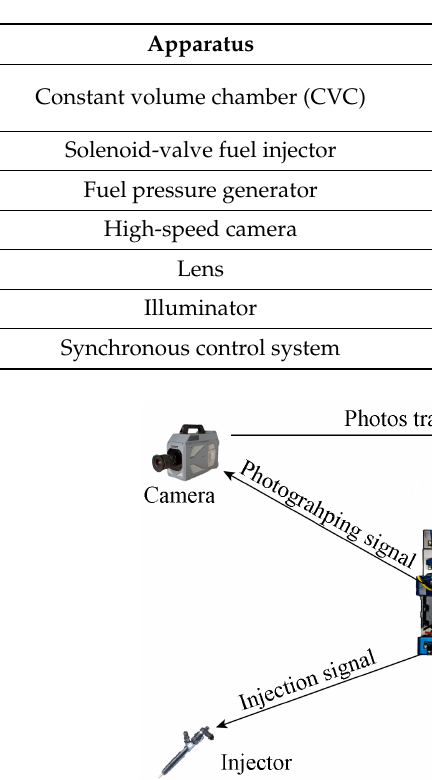
Figure 4. Schematic diagram of the visualization measurement apparatuses. Table 1. Visualization measurement apparatus specifications.